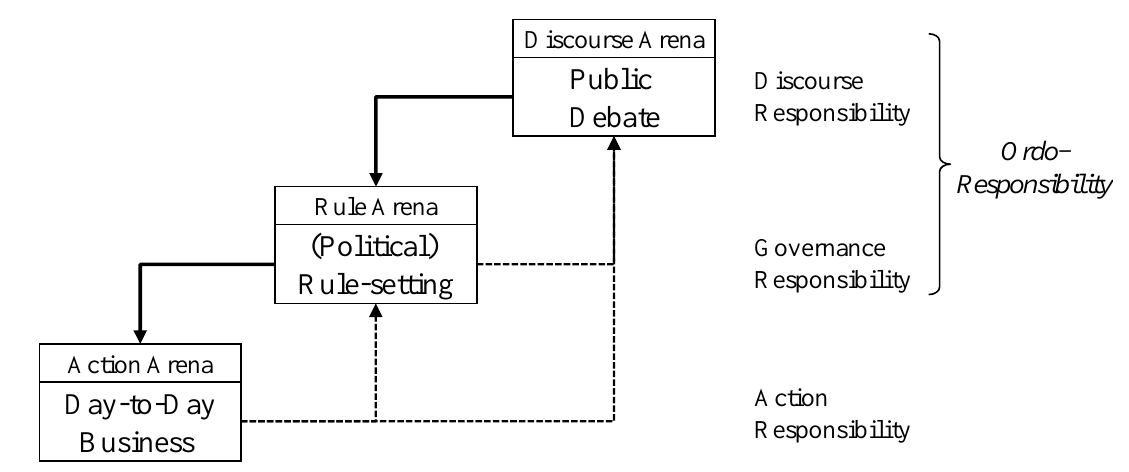
Figure 2. Three arenas of social responsibility of business firms